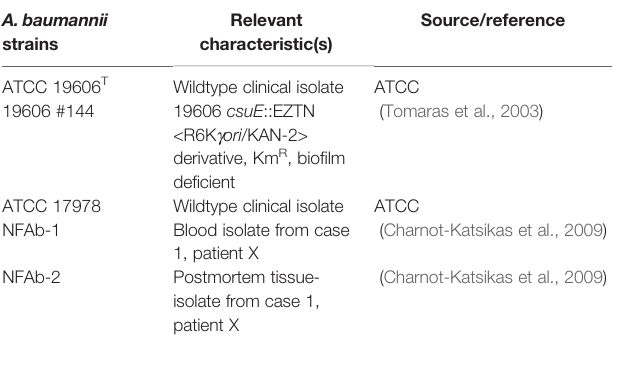
TABLE 1 | Bacterial strains and plasmids used in this